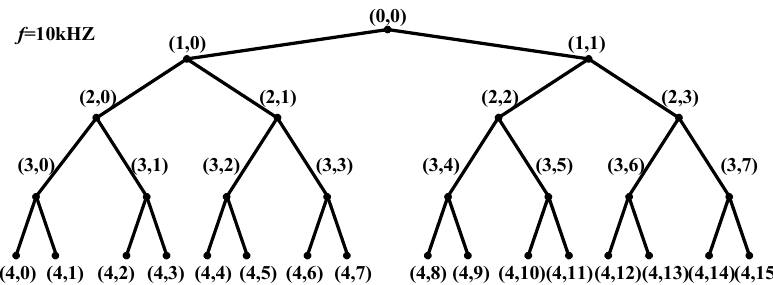
Figure 5. Schematic diagram of four-layer wavelet packet tree.